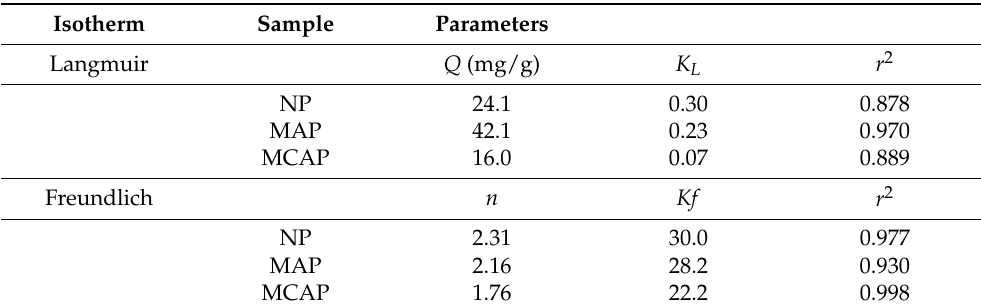
Table 5. Isotherm parameters Langmuir and Freundlich sorption for natural peat (NP), mechanically activated peat (MAP), mechanochemically activated peat